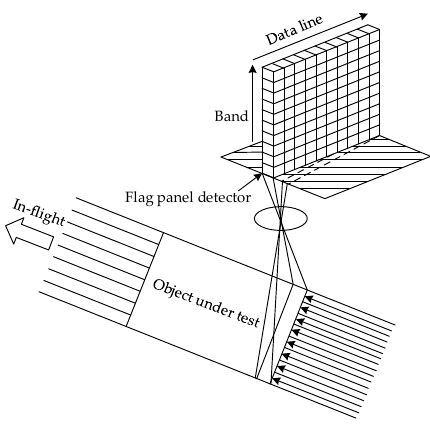
Figure 1. The imaging principle of push broom scanner.